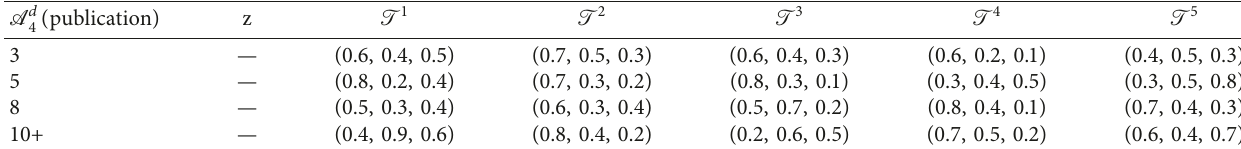
against publication. i